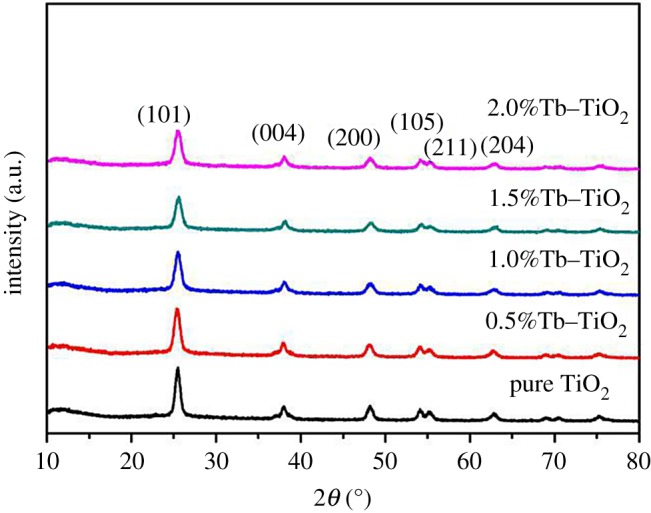
XRD patterns of Tb–TiO2 samples with different Tb doping amounts.